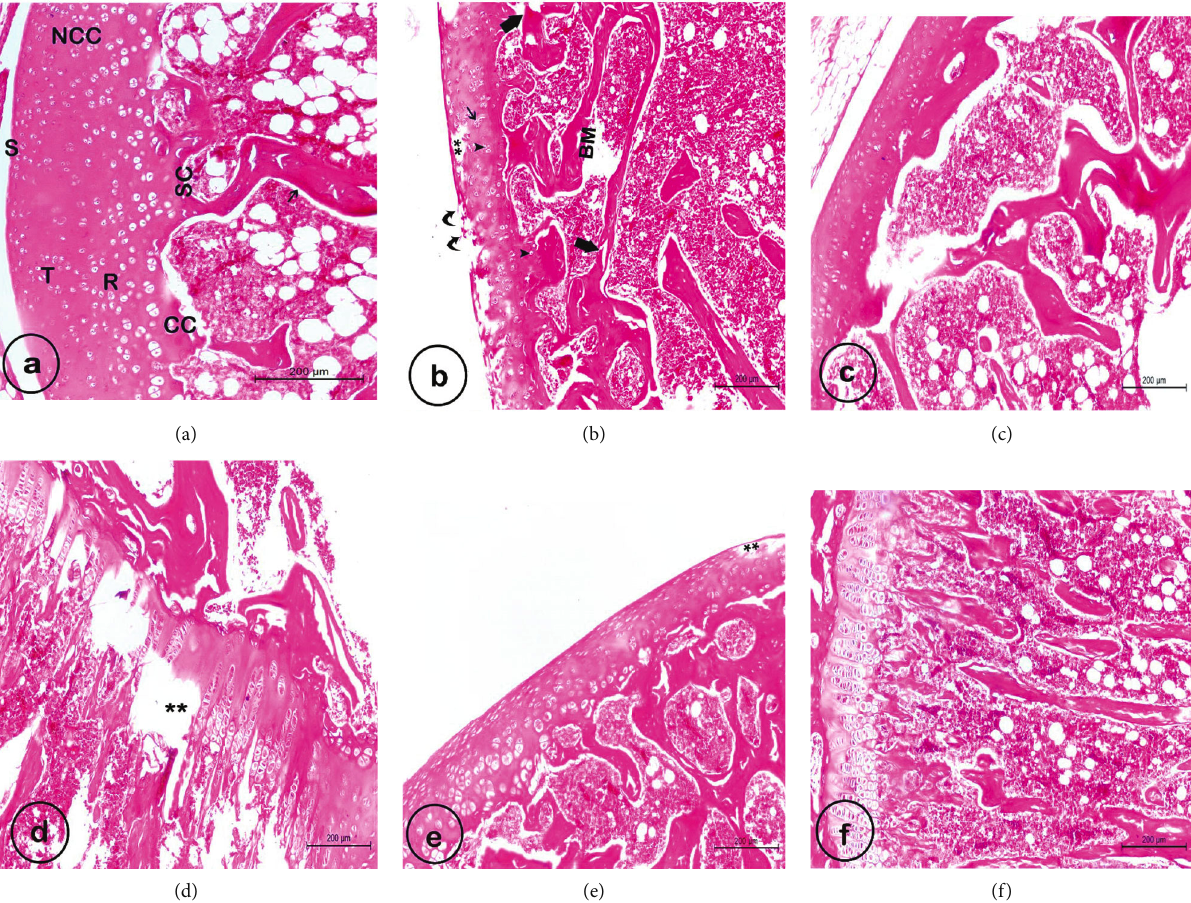
Figure 9: Photomicrographs of hematoxylin and eosin- (H&E-) stained sections of the left knee joints. (a) shows the normal control group with the normal architecture of the articular cartilage that consists of a noncalci fi ed (NCC) region, which is arranged into super fi cial (S), transitional (T), and radial (R) zones and calci fi ed (CC) region with a clear intact tidemark in between (scale bar = 200 μ m). It also shows subchondral bone (SC) with well-oriented bony trabeculae (arrow). (b) – (d) show the MIA-treated group (osteoarthritic rats), wherein (b) depicts fi ssures, surface fi brillation (curved arrows), chondrocytes with hyperchromatic nuclei (arrowheads), chondrocytes clusters (thin arrow), marked loss of (matrix and chondrocytes), and degenerated and disorganized bone trabeculae (thick arrows); (c) shows a decrease in articular cartilage thickness, unclear tidemark, an abnormal subchondral with an increase in trabecular thickness, and bone marrow space (BM) containing fewer hematopoietic cells; and (d) shows degeneration (asterisk) and heterogeneous distribution of chondrocytes in the growth plate. (e) and (f) show the treatment group (MIA+CUR-loaded PLGA NPs), wherein (e) displays a marked restoration of the normal structure of articular cartilage with an intact surface, except for some damaged parts ( ∗∗ ) and a few hyperchromatic nuclei, an increase in cellularity, a partial improvement in tidemark integrity, and nearly normal bone marrow space (BM) relative to the MIA group (scale bar = 200 μ m), and (f) demonstrates neatly and properly aligned and oriented chondrocytes of the growth plate (scale bar = 200 μ